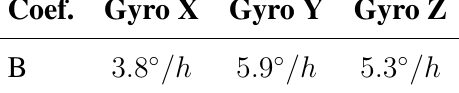
Table 5. Bias instability coefficients for IMT30 gyros. Mean value of five tests. Coef.